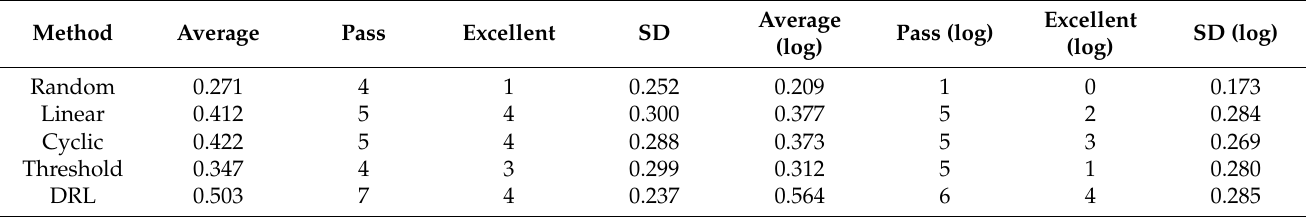
Table 3. The results of HLR that consider the knowledge point association.